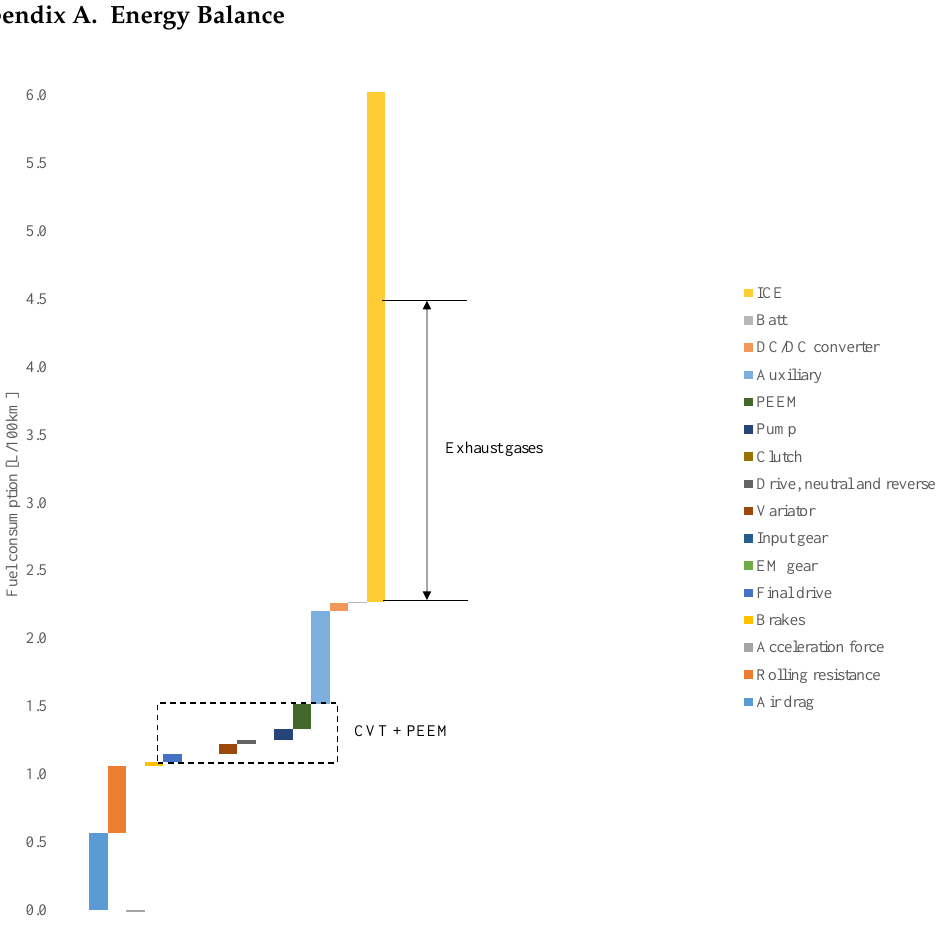
Figure A1. Energy losses of a CVT-based plug-in hybrid electric vehicle. CVT denotes the continuous variable transmission, PEEM the power electronics and electric machine, and Batt the battery.